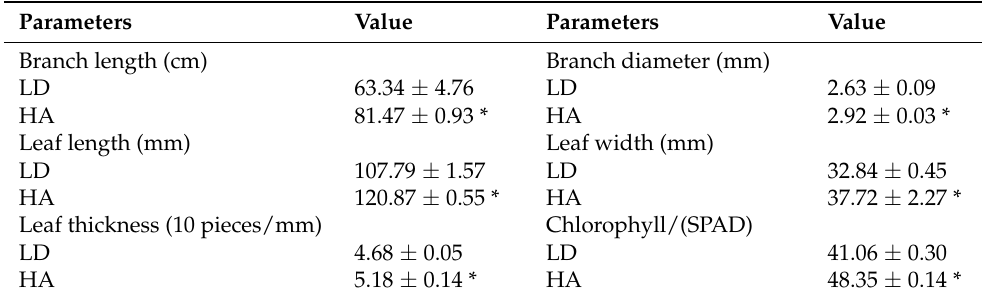
Table 1. Effects of humic acid on vegetative growth of decline diseased bayberry.